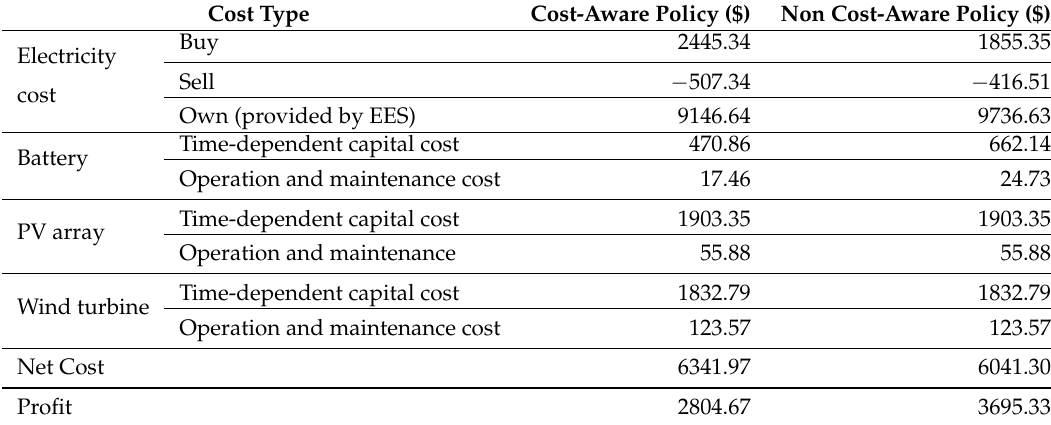
Table 4. Different cost values after one year operation by two